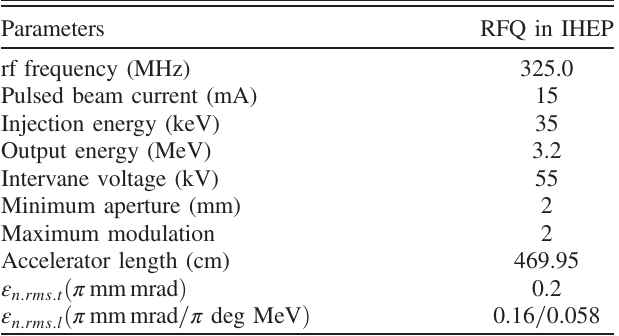
TABLE II. The main parameters of the 10 MeV test stand RFQ in IHEP.